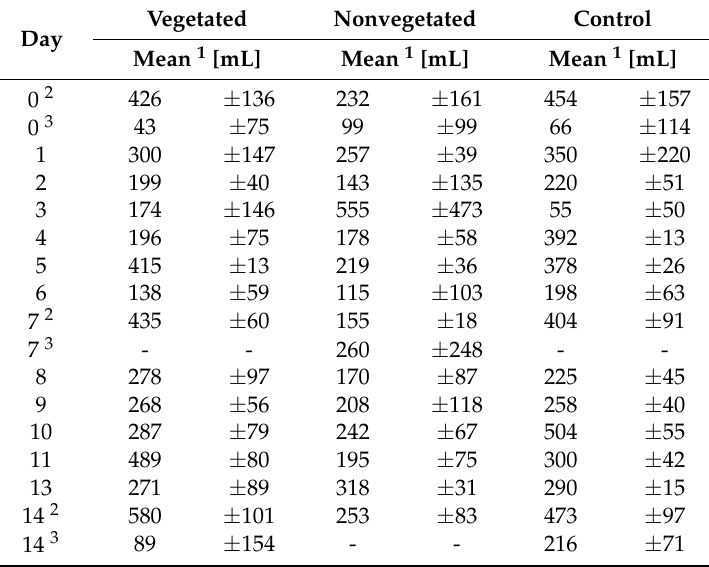
Table A3. Mean daily synthetic stormwater additions.